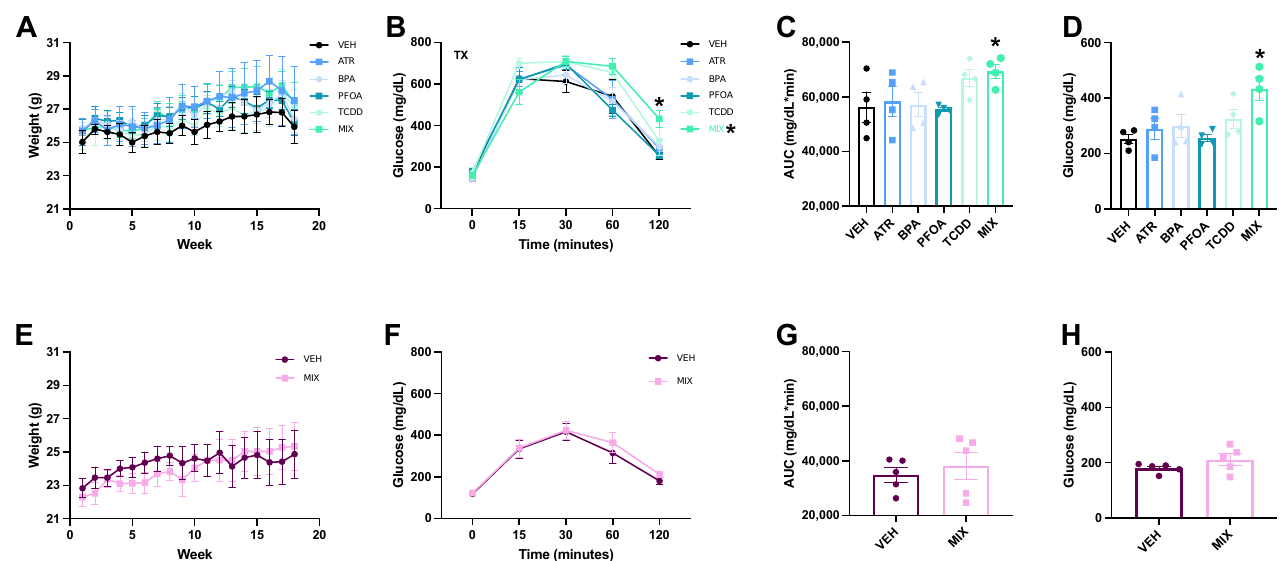
Figure 1. Weekly Weights and Glucose Tolerance Tests. ( A ) Dams were weighed weekly following weaning until the glucose tolerance test with no change in weight between groups at any week. Twenty-one weeks following the cessation of EDC exposures a glucose tolerance test was performed. ( B ) A marginally significant interaction was present when performing a repeated-measures ANOVA on the glucose concentrations over time in MIX dams with a significant effect of MIX at 120 min. ( C ) Only in the MIX dams was there a significantly elevated glucose area under the curve. ( D) MIX dams also had significantly elevated glucose at the completion of the test; full data points displayed. ( E ) Non-pregnant female mice were weighed weekly three weeks after the cessation of exposure to mirror dams with no difference in weight at any week. ( F ) Non-pregnant MIX dams did not have a difference in blood glucose at any time point of the glucose tolerance test. ( G ) The non-pregnant MIX female mice did not have any difference in glucose area under the curve. ( H ) Non-pregnant MIX female mice did not differ in blood glucose at 120 min after the glucose injection. Data are reported as mean ± standard error ( n = 4 – 5/group). Asterisk indicates p ≤ 0.05.